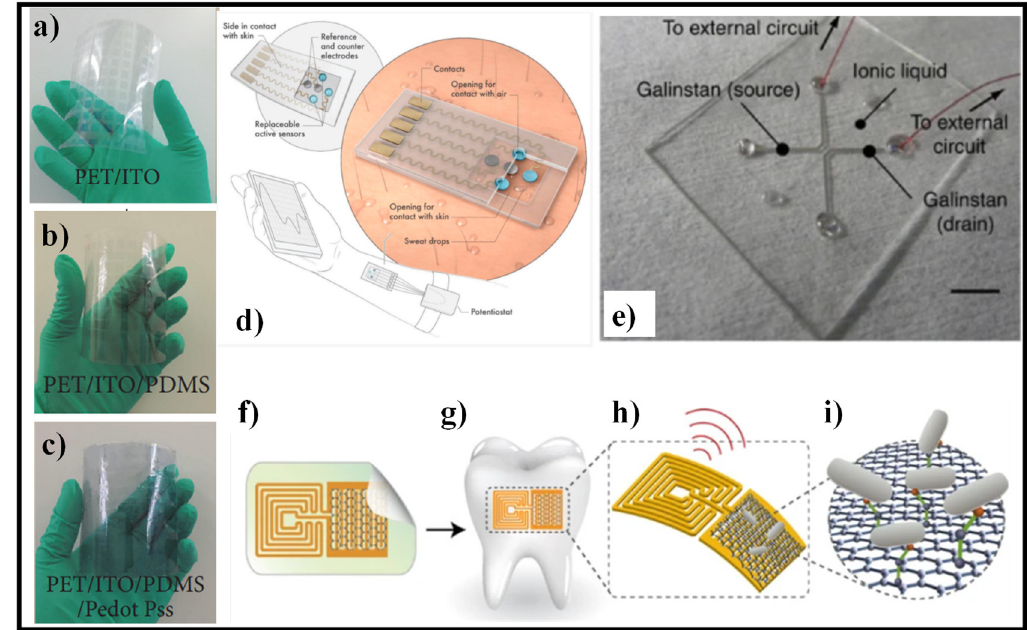
Figure 10. Flexible substrates for biosensors, ( a – c ) PDMS- and PEDOT:PSS-based pressure sensor [139], ( d ) wearable sweat sensor based on MXene [143], Reproduced with permission from [143]. John Wiley & Sons, Inc., 2019, ( e ) fully fabricated liquid heterojunction device, consisting of an ionic liquid active channel and GaInSn source/drain electrodes [144], ( f ) graphene-based wireless nanosensor [145], ( g ) biotransfer of the nanosensing architecture onto the surface of a tooth [145], ( h ) magnified schematic of the sensing element, illustrating wireless readout [145], ( i ) binding of pathogenic bacteria by peptides self-assembled on the graphene nanotransducer [145].